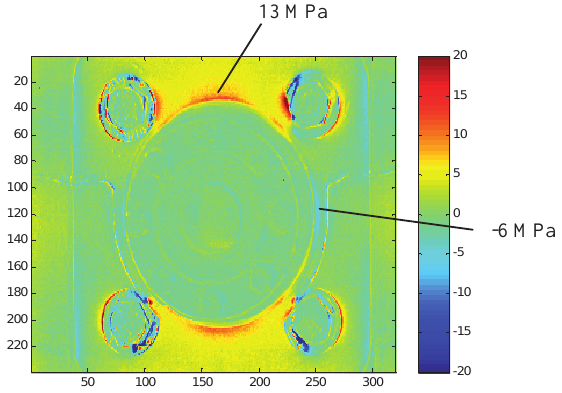
Fig. 9. TSA obtained for the centrifugal load applied at 1 Hz